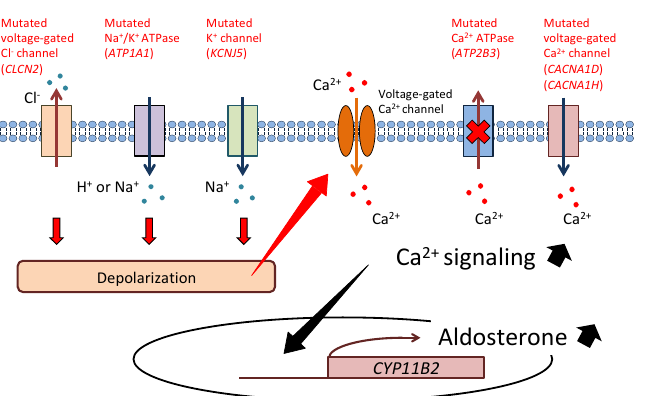
Figure 1. Cellular mechanism of aldosterone synthesis in aldosterone-producing adenoma. Mutations of KCNJ5 , ATP1A1, and CLCN2 lead to depolarization of the cell membrane due to impairment of ion transport. Depolarization activates voltage-gated Ca 2+ channels and increases intracellular Ca 2+ levels. Conversely, mutations of CACNA1D and CACNA1H directly cause an increase in Ca 2+ conductance. ATP2B3 mutation reduces Ca 2+ export from the cell. Activated calcium signaling promotes transcription of aldosterone synthase ( CYP11B2 ), resulting in overproduction of aldosterone.